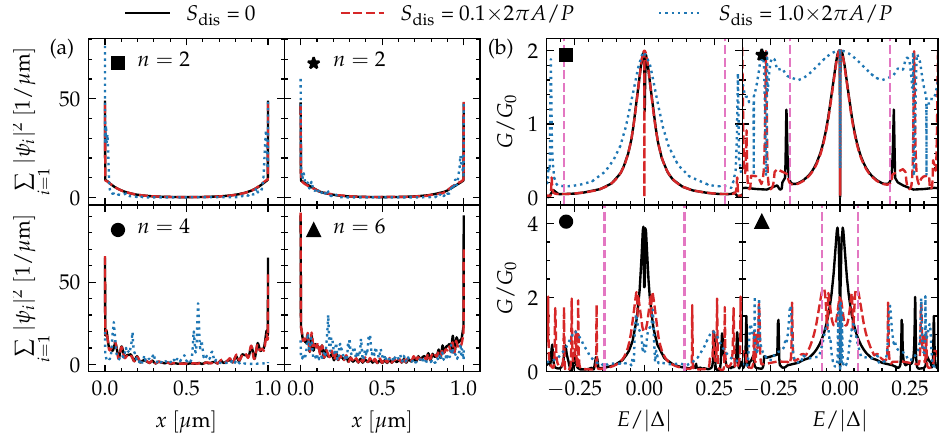
Figure 4. The ( a ) one-dimensional wave function density summed over the n lowest-energy (in absolute value) solutions and ( b ) tunneling conductance as a function of energy of a 1 µ m-long top- proximitized TI nanoribbon with and without disorder with different disorder strengths (indicated in Figure 1c) for four different combinations of chemical potential and piercing magnetic flux (also indicated in Figure 1c). The tunneling conductance in ( b ) corresponds to the vertical gray dashed line cuts in Figure 3d–f. The spectral gap of the TI nanoribbon considering infinite length and no disorder is indicated by vertical pink dashed